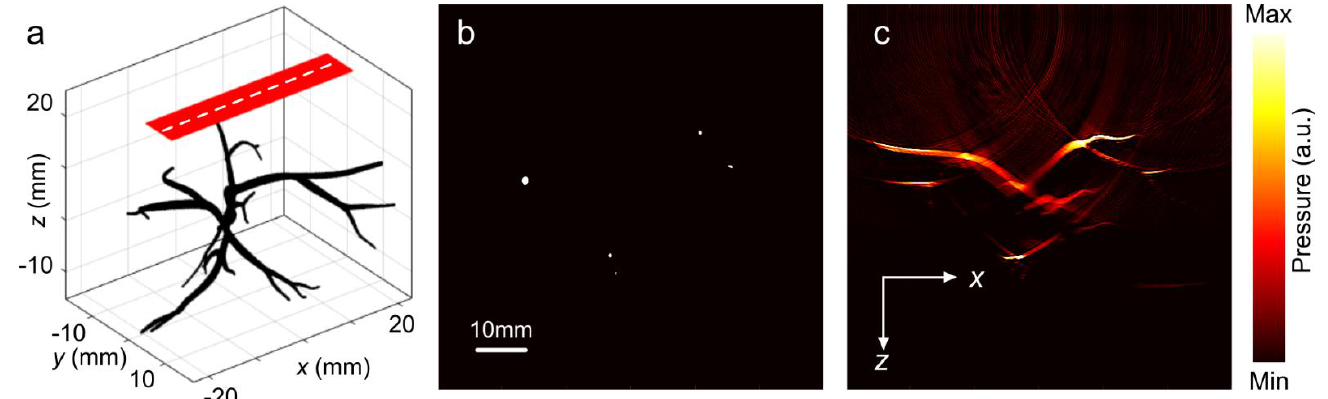
Figure 4. Photoacoustic imaging simulation of one of the example vasculature phantoms. ( a ) Three- dimensional visualization of the vasculature phantom (black color) and linear array L7-4 (red color), ( b ) cross-section (along white dashed line in b) of initial pressure, ( c ) reconstructed image .